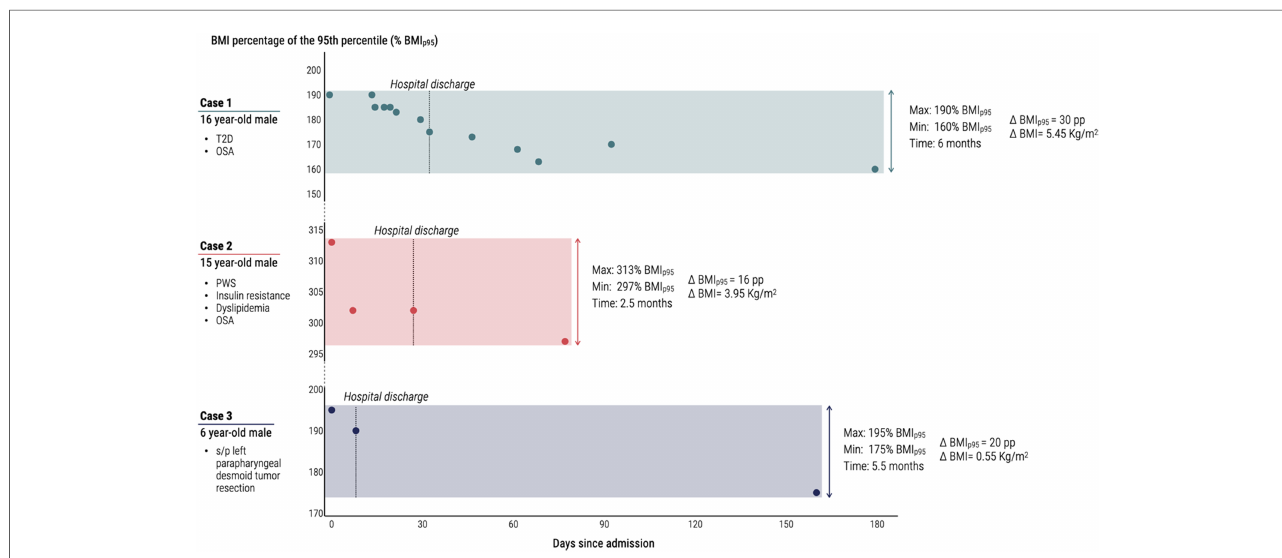
FIGURE 3 Change in BMI percent of the 95th percentile over time for three pediatric cases of inpatient obesity medical management. T2D, type 2 diabetes; OSA, Obstructive Sleep Apnea; PWS, Prader-Willi Syndrome; BMI, body mass index; Kg/m 2 , kilograms per meter squared; % BMI p95 , BMI percentage of the 95th percentile; pp, percentage points; Δ BMI p95 , change in BMI percentage of the 95th percentile; Δ BMI, change in absolute